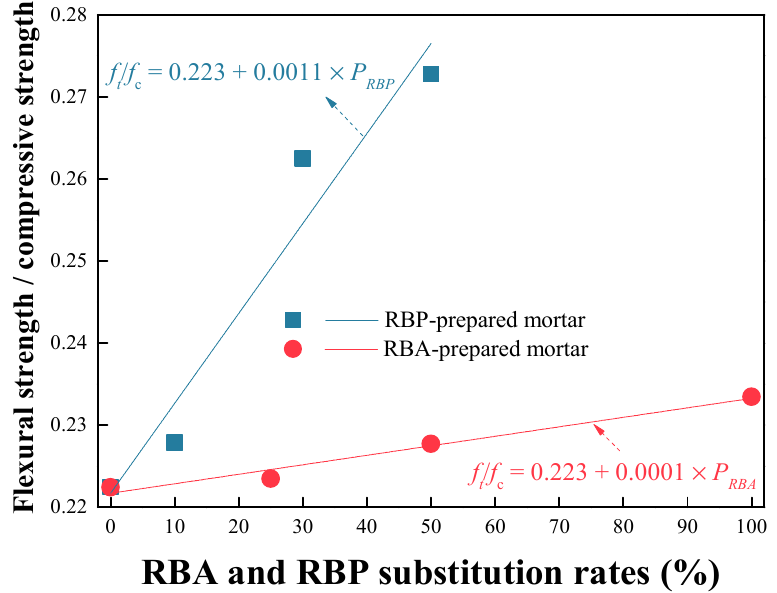
Figure 11. Flexural strength to compressive strength of mortar with RBA and RBP.